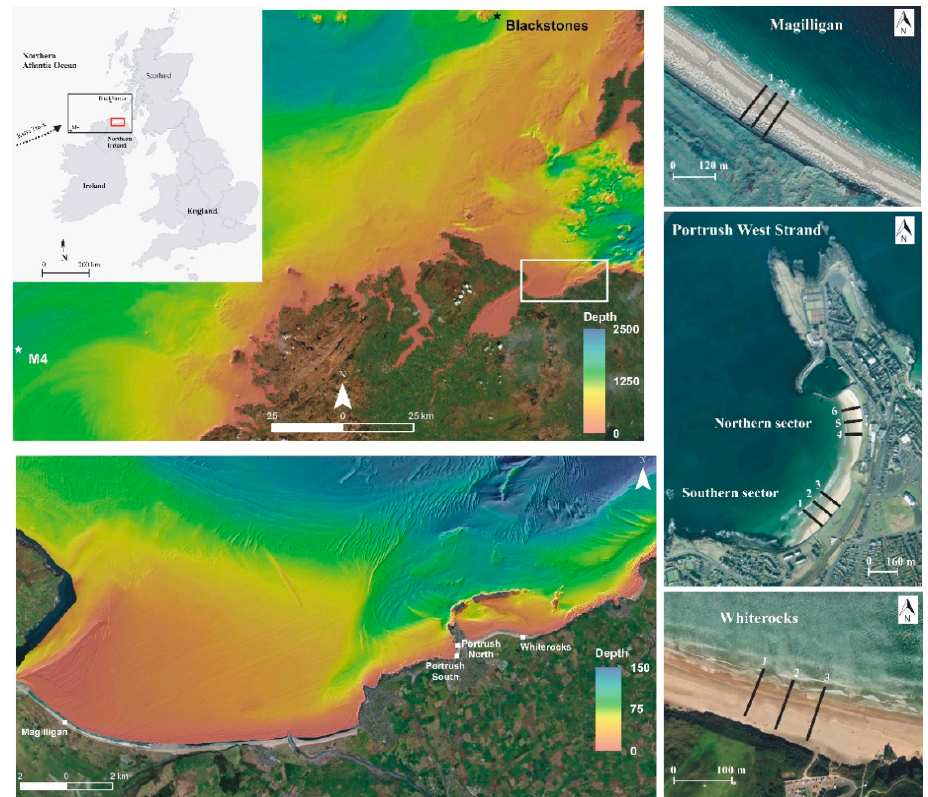
Figure 2. Location map with used grid for wave propagation and offshore buoys. Table 1. Main attributes of selected sites.